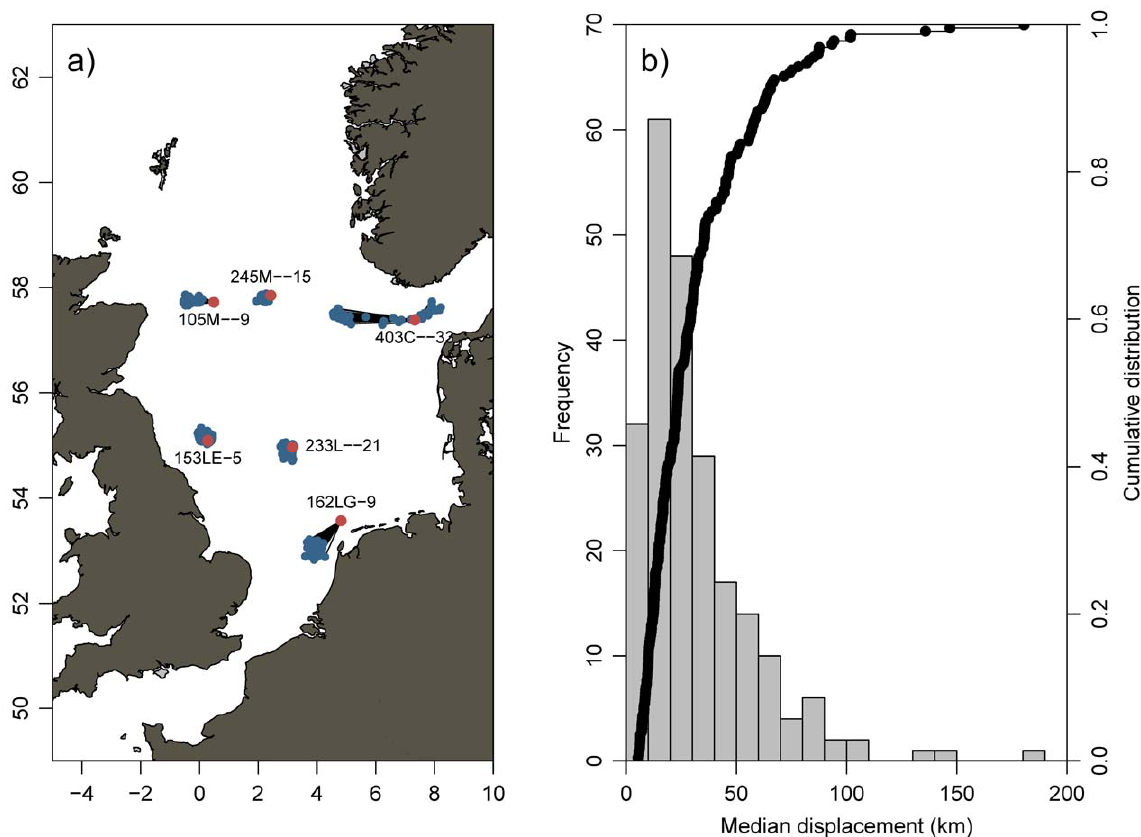
Figure 3. Backtracking simulations. a) Examples of backtracked trajectories for six observations of larval in the CPR distributed across the North Sea. Red circles mark capture points in the CPR, blue circles the end points of particles after 10 days of backtracking. Black lines connect the two points for visual reference. Text denotes the CPR label code. b) Distribution of particle displacements after 10 days drift. Left axis (grey bars) depict the frequency (number of CPR observations containing larvae) for each 10km class bin. Black-line with black dot (right axis) shows the empirical cumulative distribution function.